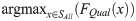
Models designed through evolutionary model discovery insights are significantly more robust.Comparison between the RMSE of 100 runs of three models with farm selection strategies designed taking into consideration the insights from evolutionary model discovery, 1) argmaxx∈SAll(FQual(x)), 2) argmaxx∈SAll(5FSoc(x)+6FQual(x)), and 3) argmaxx∈SAll(3FMig(x)+5FQual(x)), against 100 runs of the original farm selection strategy argmaxx∈SAll(-FDist(x)) in [21, 22, 43, 44], under random initialization of parameters. The three farm selection strategies derived from evolutionary model discovery were far more robust under random parameter initialization and showed significantly better RMSE scores compared to the original model.